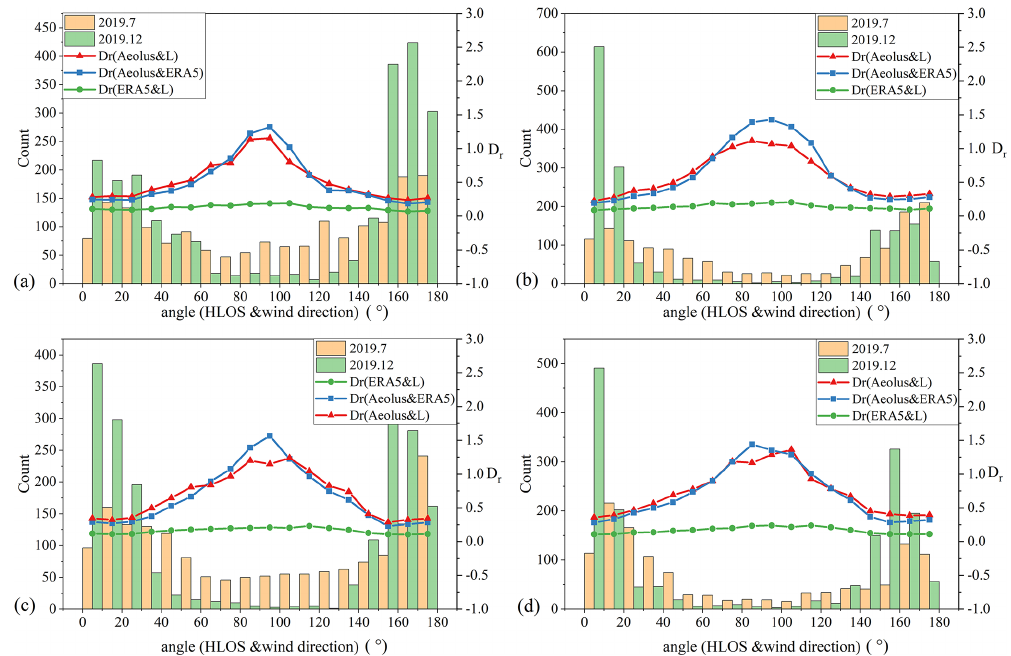
Figure 10. Statistical distribution at different angles (HLOS and wind direction) about the data points and mean relative errors from the Rayleigh-clear group data. The relative error D r in the figure was calculated from the 12-month data of the region; (a) Chifeng, (b) Baoshan, (c) Shapingba, and (d) Qingyuan.